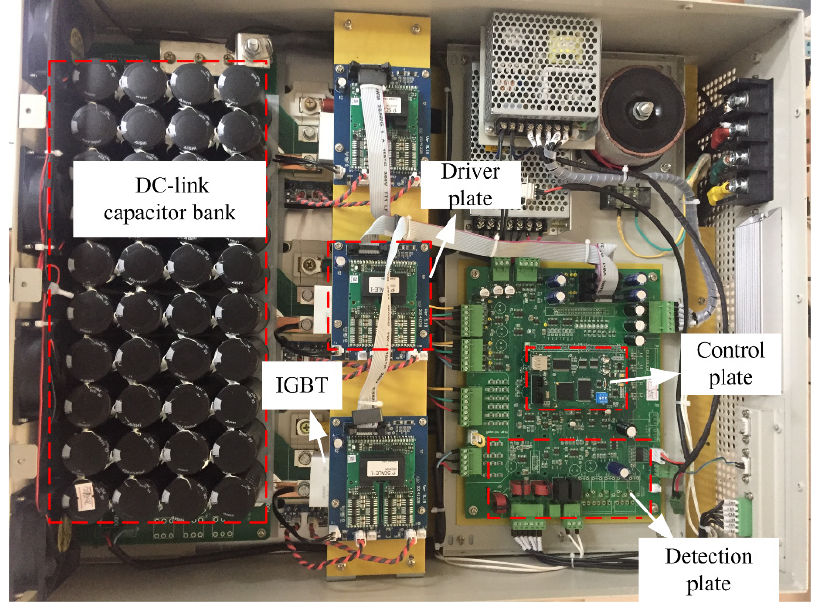
Figure 7. Experimental prototype of 100kVA SVG.